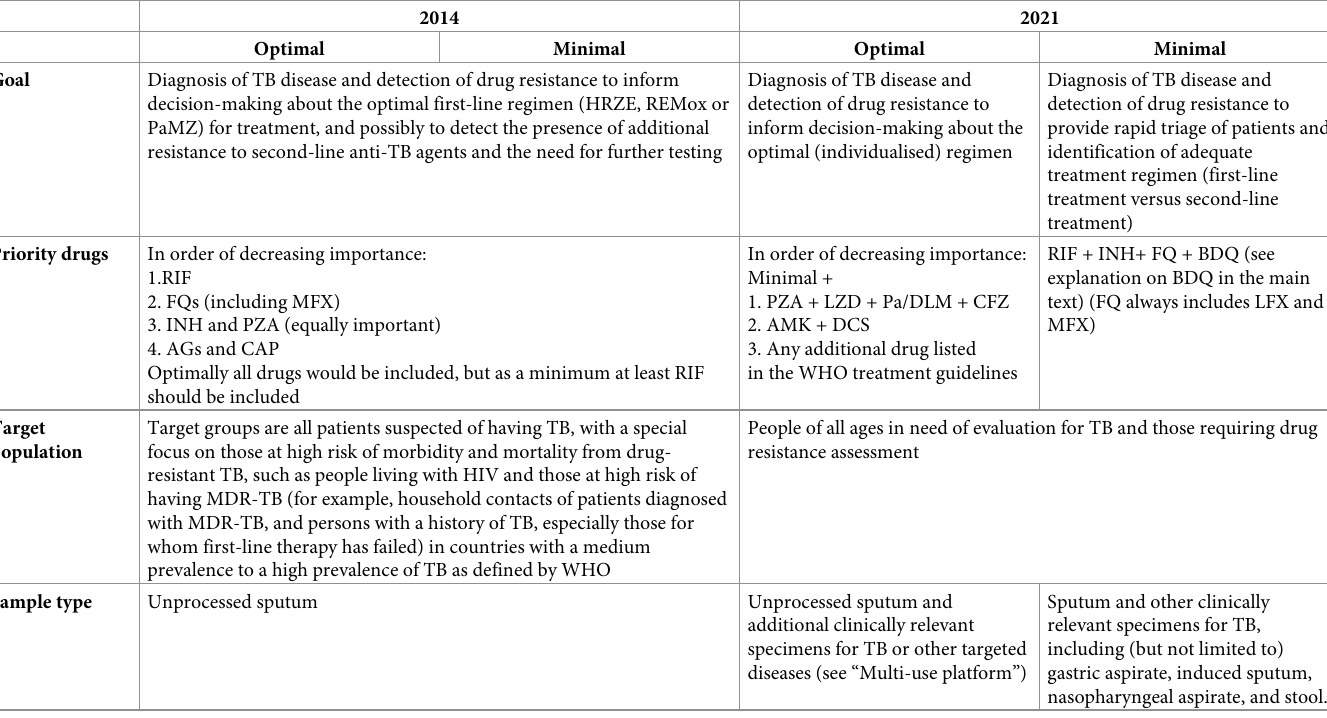
Table 1. Key changes between 2021 and 2014 TPPs for peripheral TB drug-susceptibility testing. 2014 2021 Optimal Minimal Optimal Minimal Goal Diagnosis of TB disease and detection of drug resistance to inform decision-making about the optimal first-line regimen (HRZE, REMox or PaMZ) for treatment, and possibly to detect the presence of additional resistance to second-line anti-TB agents and the need for further testing